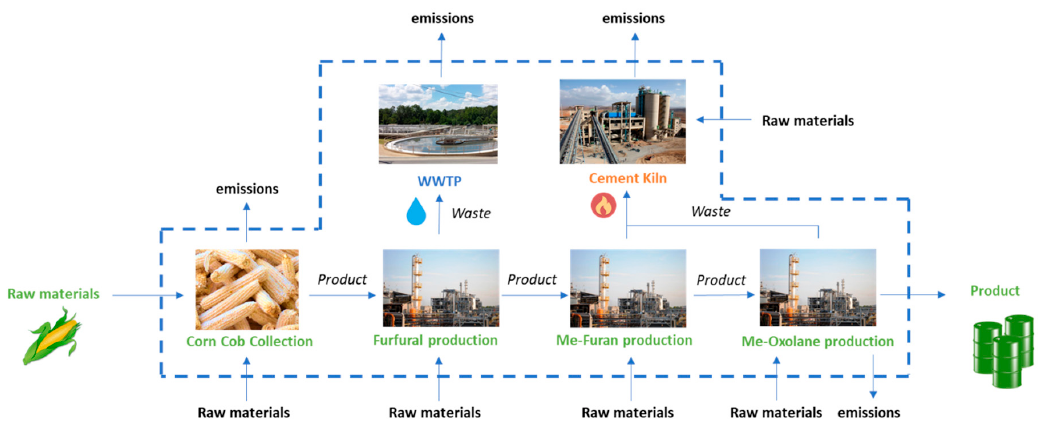
Figure 7. Life cycle assessment boundaries for 2-MeOx.